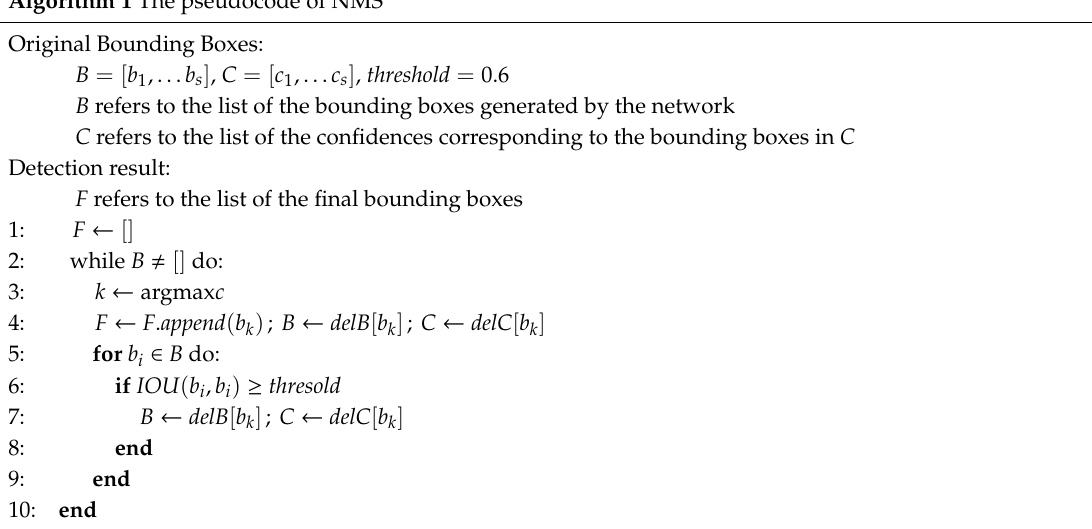
Algorithm 1 exhibits the detailed steps of NMS for our approach: Algorithm 1 The pseudocode of NMS